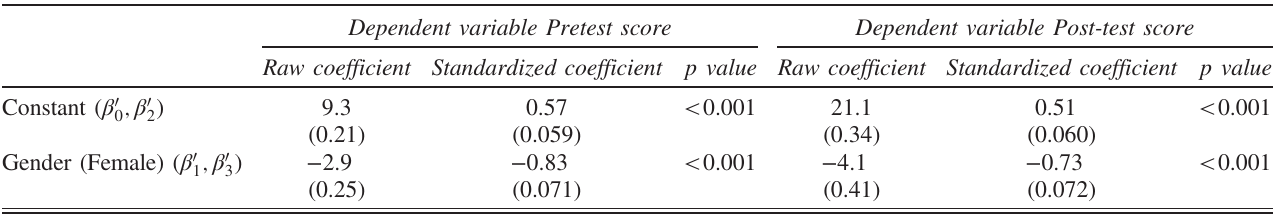
TABLE II. Raw and standardized coefficients for two simple linear regression models with PCSSW dataset and gender as the only explanatory variable. The first model uses pretest score as the dependent variable, while the second model uses post-test score as the dependent variable. t statistics and p values are identical to those obtained from independent samples t tests or repeated measures analysis. Standardized coefficient estimates are similar to those obtained using Cohen ’ s d , while raw coefficients are identical to those obtained from repeated measures